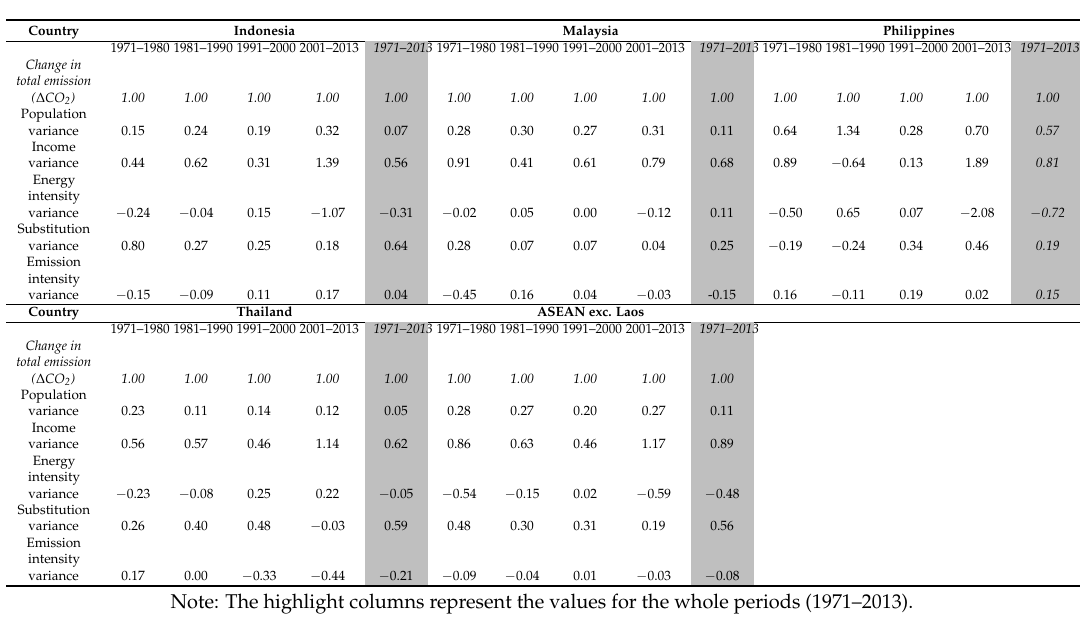
totalemission ( ∆ CO 2 )